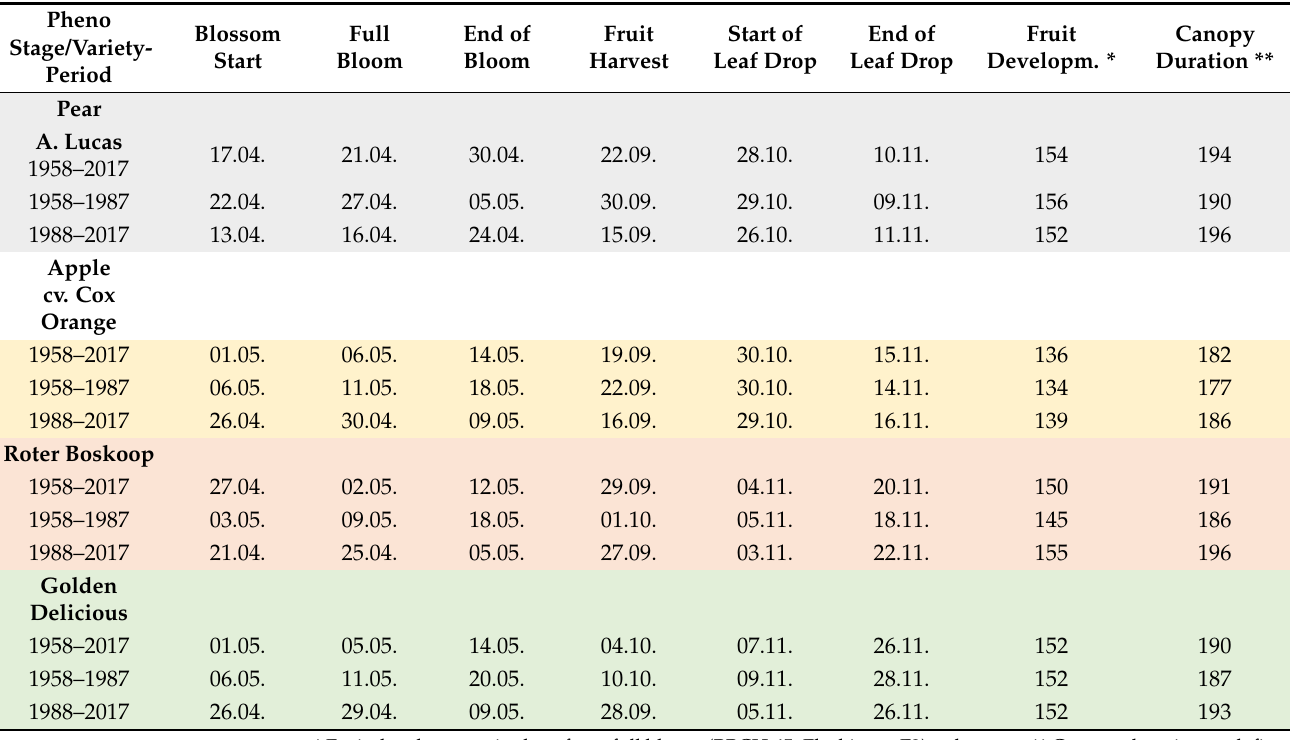
Table 3. Phenological data of apple and pear trees from 1958 to 2017 in Klein-Altendorf.